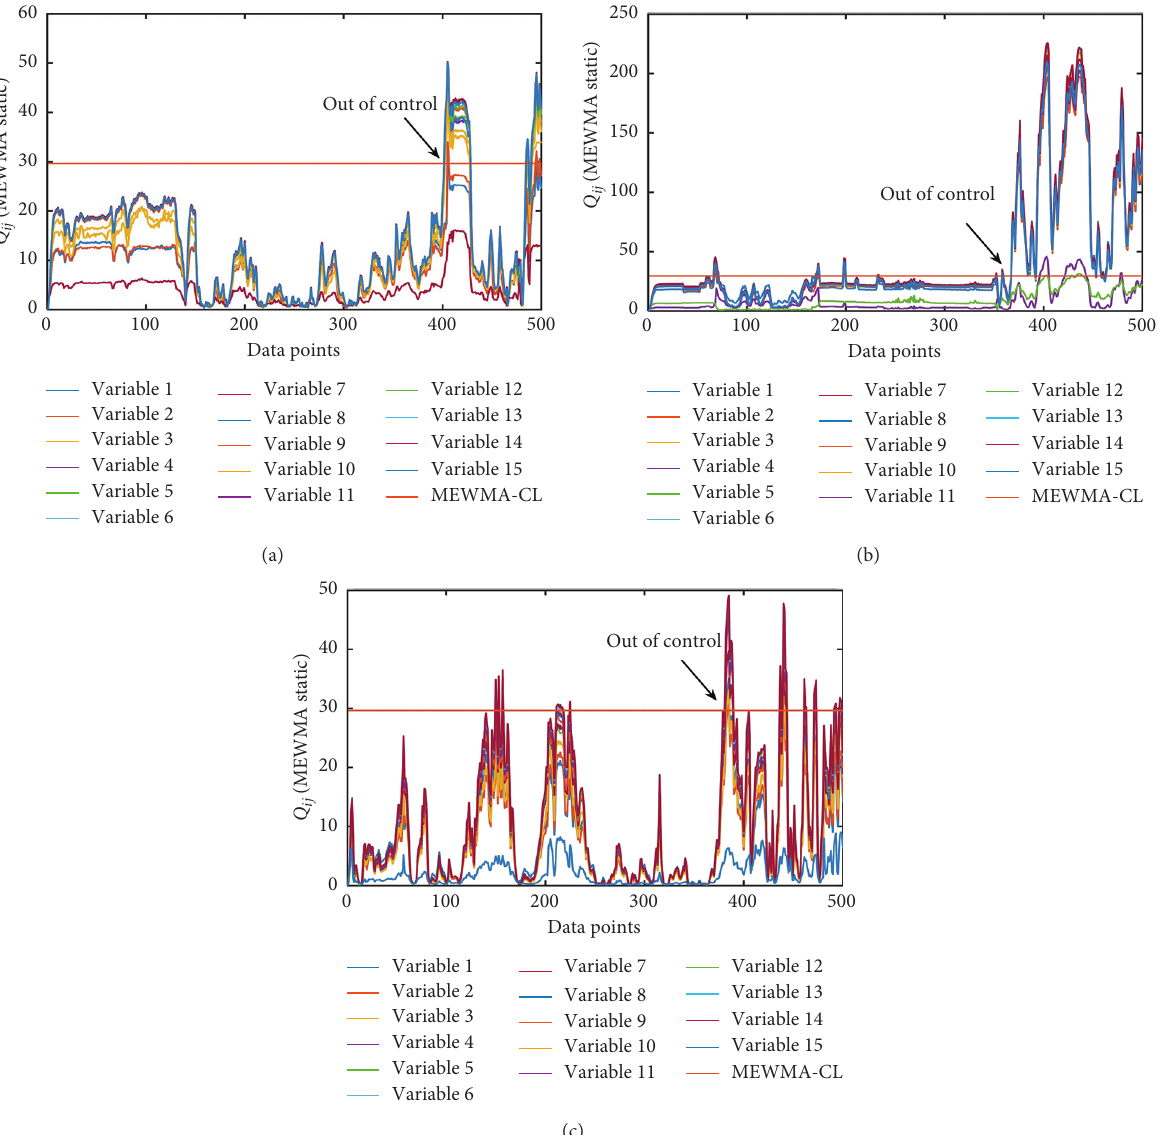
Figure 8: Multidimensional SCADA data monitored by the MEWMA control chart with (a) anomaly A, (b) anomaly B, and (c) anomaly